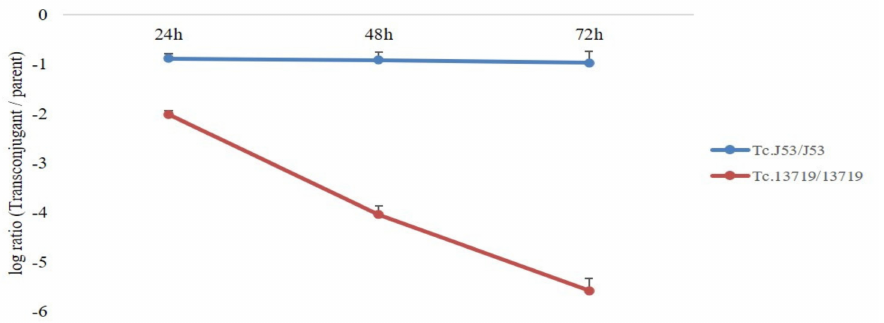
Figure 3. Competitive growth kinetics. Dynamics of replicate competition experiments for parent strains, E. coli J53 and E. coli NCCP 13719, and their transconjugant containing the bla CMY-2